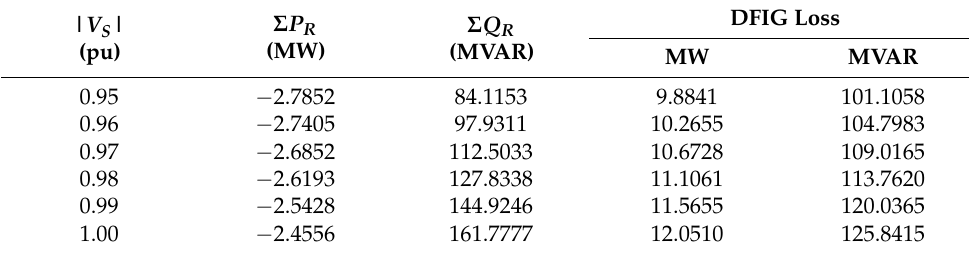
Table 10. Rotor power and DFIG power loss ( V w = 9 m/s).